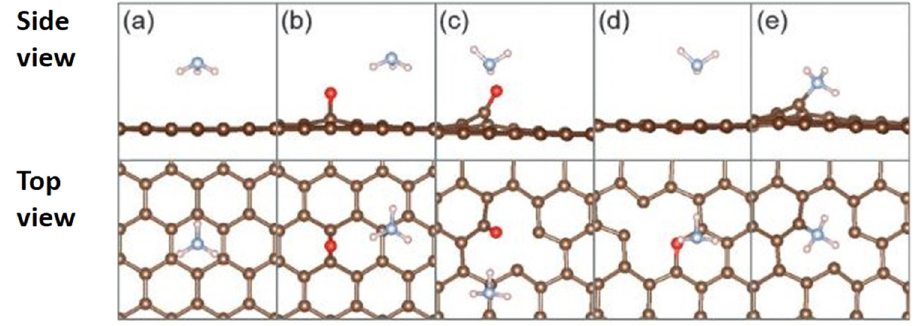
Figure 8: Optimized structures of the NO 2 molecule adsorbed on ( a ) pristine graphene, ( b ) sp 3 - type defect ( epoxy group )- graphene, ( c ) sp 3 - type defect ( carbonyl group )- graphene, ( d ) sp 3 - type defect ( ether group )- graphene, and ( e ) single vacancy of graphene. The red, brown, and grey colours represent O, C, and N atoms, respectively. Reproduced from ref. [ 105 ]